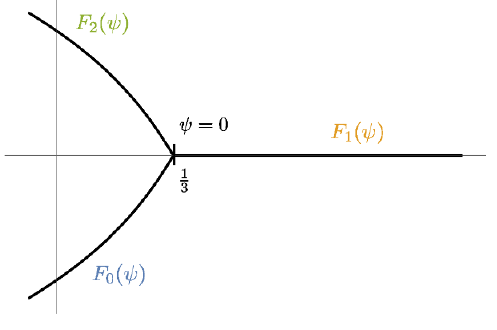
(a) Parametric dependence of the periods along the negative -axis. (b) Wall of marginal stability. Figure 45. Stability of the large volume D2-brane.